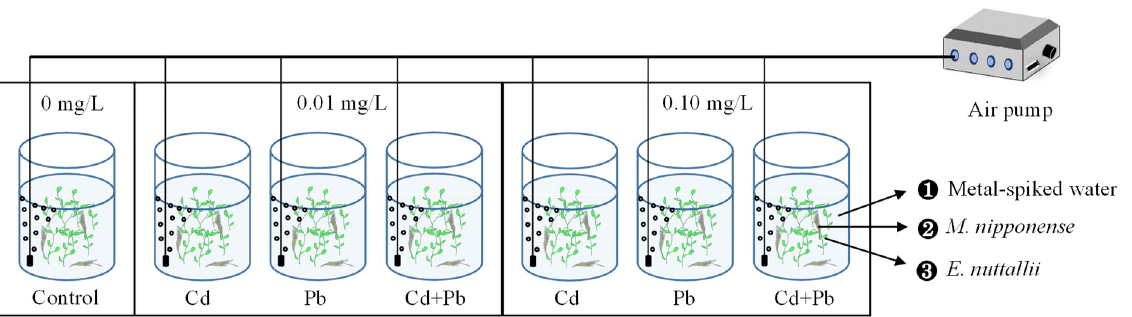
Figure 1. Schematic diagram of chronic toxicity tests (28 days) with M. nipponense exposed to two concentration gradients for water spiked with Cd, Pb and their mixture